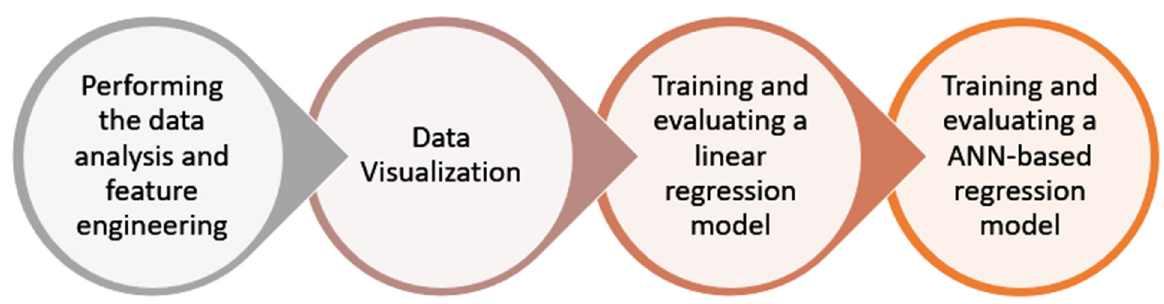
Figure 2. Machine learning-based regression framework.